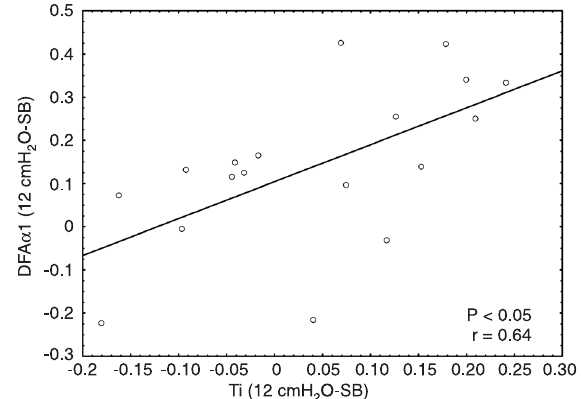
Figure 2. Correlation between detrended fluctuations analysis (DFAα1) index (short-term correlation properties of R-R inter - vals (R-Ri)) and Ti (inspiratory time). Delta between 12 cmH 2 O and spontaneous breathing (SB) of the ventilatory variables and heart rate variability values. Spearman